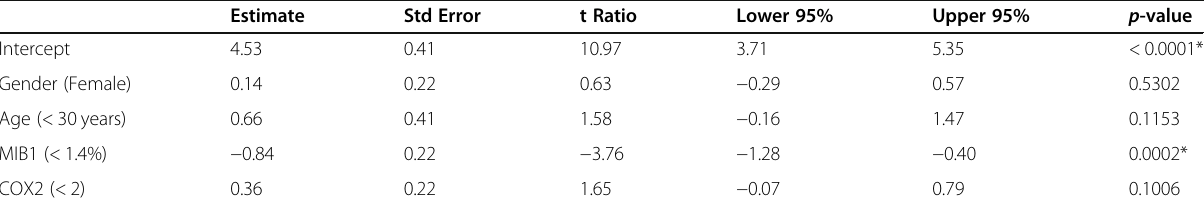
Table 3 Results of the nominal logistic regression of percentual volumetric tumor growth Estimate